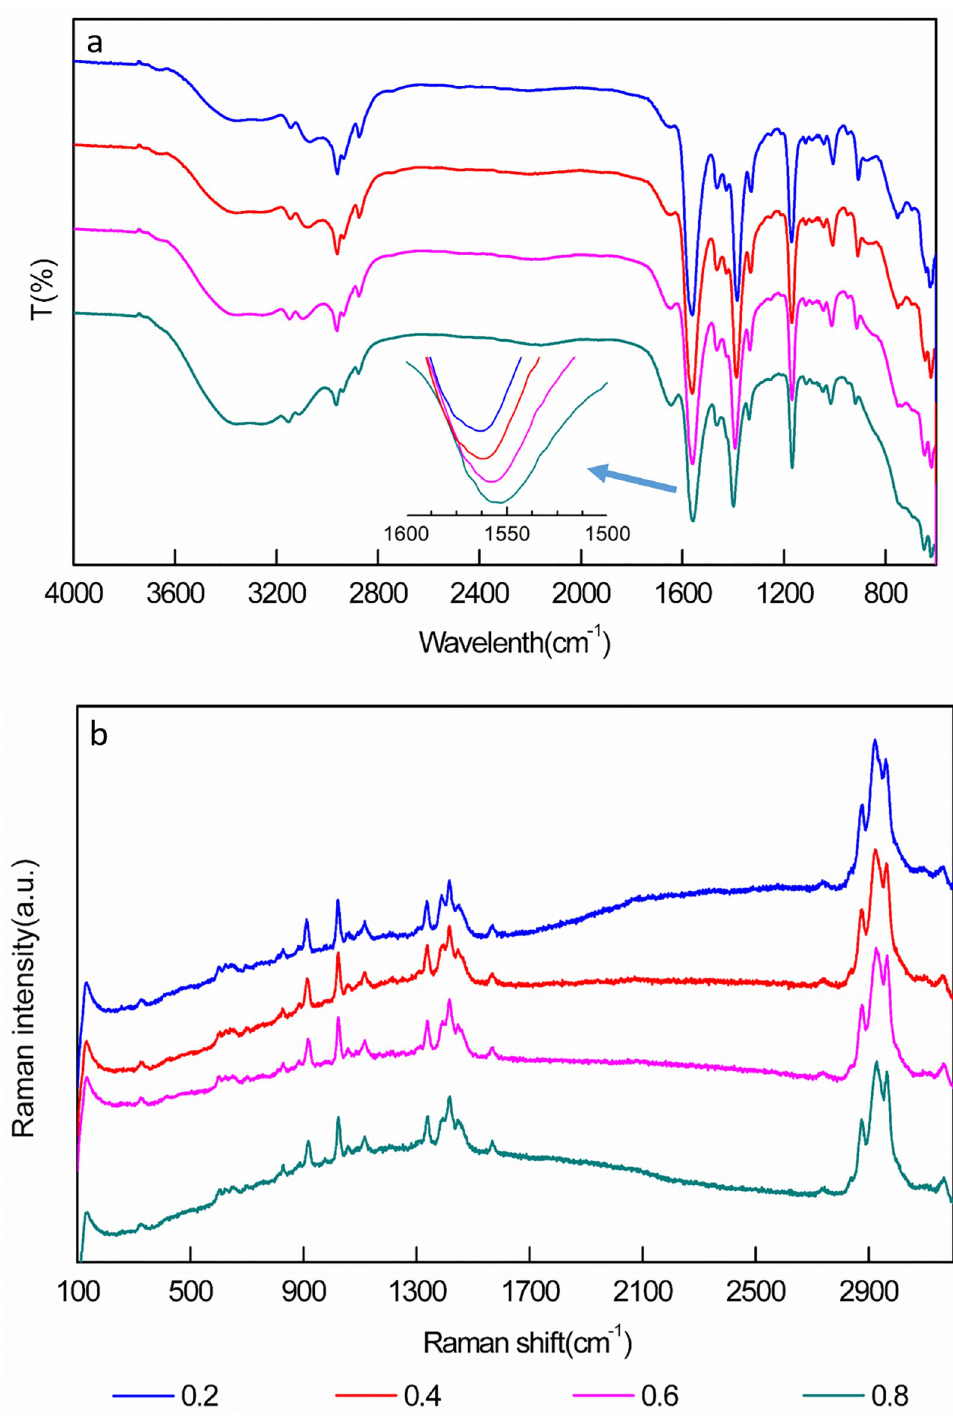
Fig 1. FTIR (a) and Raman spectra (b) of [C4mim]Ac in aqueous solutions with different IL/water mole fractions.